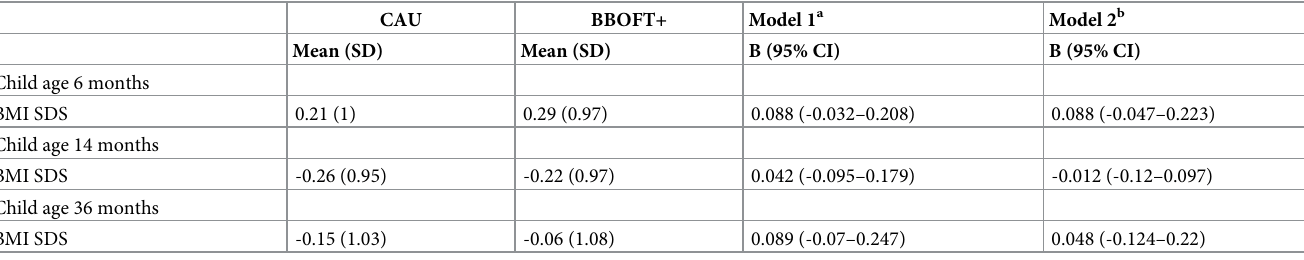
a Model 1: Adjusted for YHC team cluster b Model 2: Adjusted for YHC team cluster, background characteristics (child ethnic background (Dutch vs Non-Dutch), mother’s educational level, mother’s BMI SDS, child’s birthweight) and child’s age at